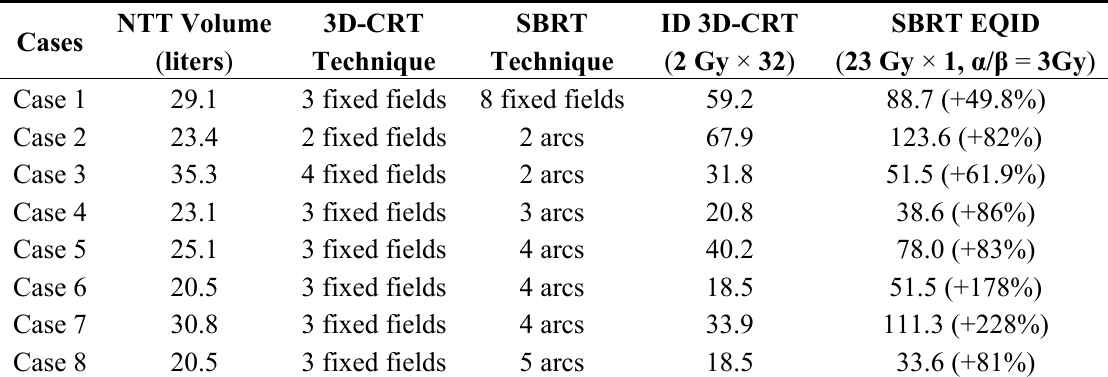
Table 3. Non-Tumour Integral Dose (Gy × liter) and increase percentage of SBRT respect to 3D-CRT. Abbreviations: ID = integral dose; 3D-CRT = three-dimensional conformal radiotherapy; SBRT = stereotactic body radiation therapy; EQID = integral dose normalized. Statistically significant difference were found ( p = 0.002).